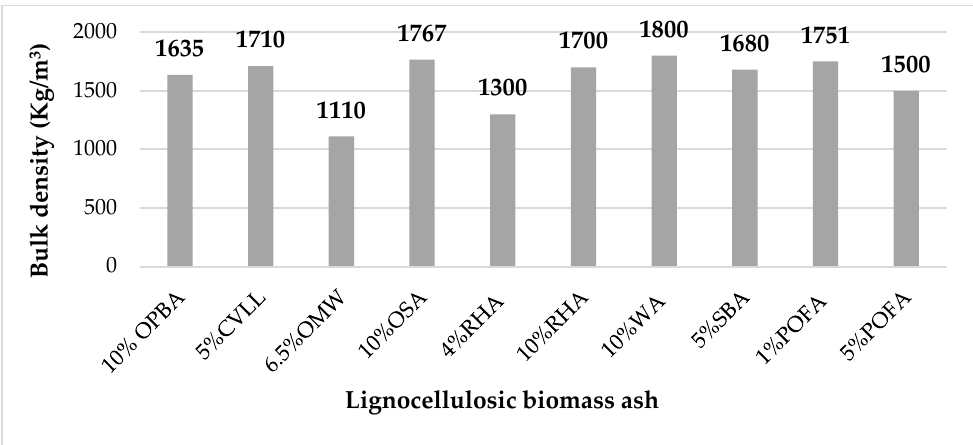
Figure 5. Bulk density for samples made with lignocellulosic biomass ash: 10% OPBA [60], 5% CVLL [61], 6.5% OMW [63], 10% OSA [62], 4% RHA [31], 10% RHA [65], 10% WA [65], 5% SBA [66], 1% OPFA [70], 5% OPFA [69].